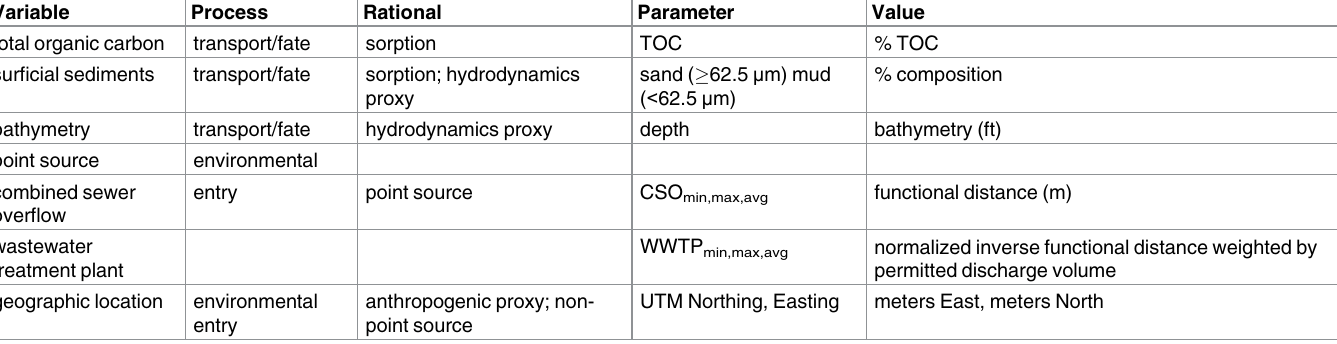
Table 1. Explanatory variables for the triclosan Random Forest model with the rational for inclusion. Three different parameterizations (minimum, maximum, and averagevalues)of the two point source variableswere includedin the models.